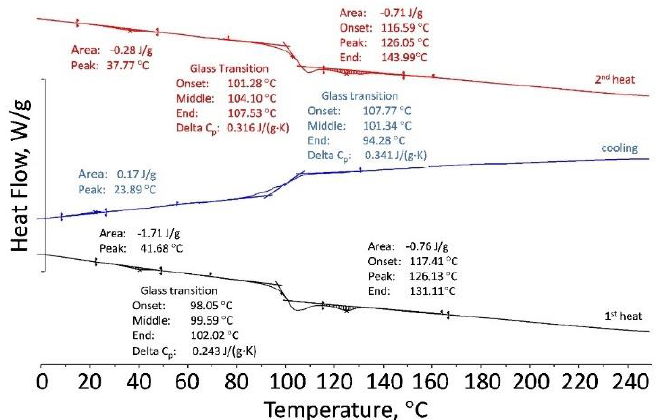
Figure 11. DSC curves of the 50Al 2 O 3 /50PLA composition.